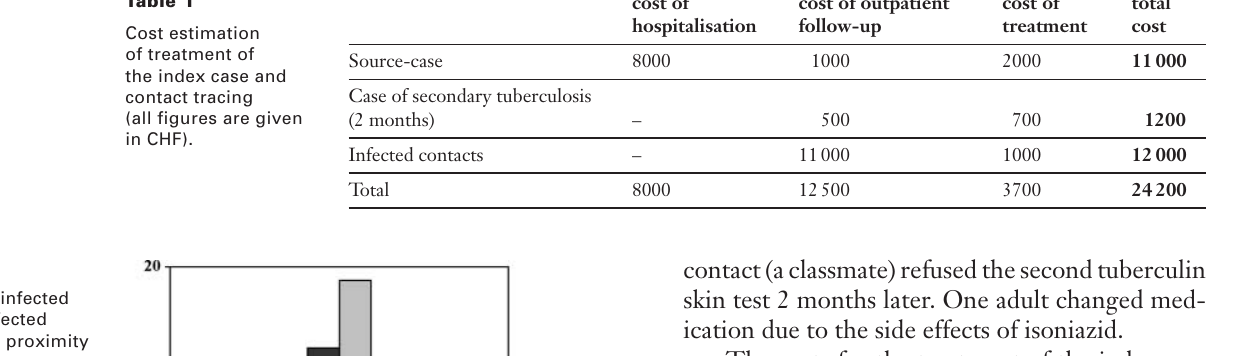
Number of infected and non infected contacts by proximity group.